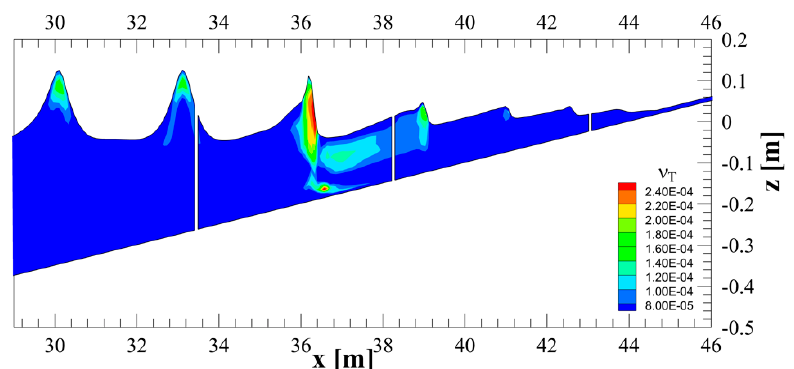
Figure 1. Test 1. Spilling breaking wave. Instantaneous free-surface elevation and contour of the eddy viscosity, ν t , obtained using the proposed WTENO model.